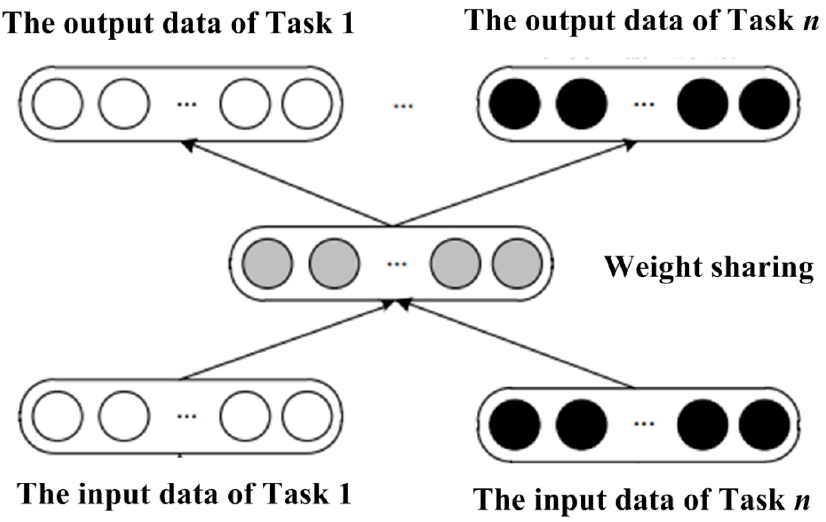
Figure 2. The information sharing mechanism of the MTL method. In the IES, various energy subsystems, such as electric energy subsystem, heat energy subsystem, cooling energy subsystem, and gas energy subsystem, are coupled by energy flow through different energy conversion equipment, including CCHP units, electric boiler, gas boiler, electric refrigerator, absorption refrigerator, etc. According to the description in Section 1.2, there exist a strong coupling relation among different energy subsystems. A large amount of energy conversion sharing information exists in the data, which are difficult to be extracted and summarized by traditional manual feature extraction methods. Therefore, the MTL method is combined into the multi-energy load forecasting model, which can effectively employ the complicated sharing information of electricity, heat, cooling, gas, and other energy conversion, help machine learning and bionic